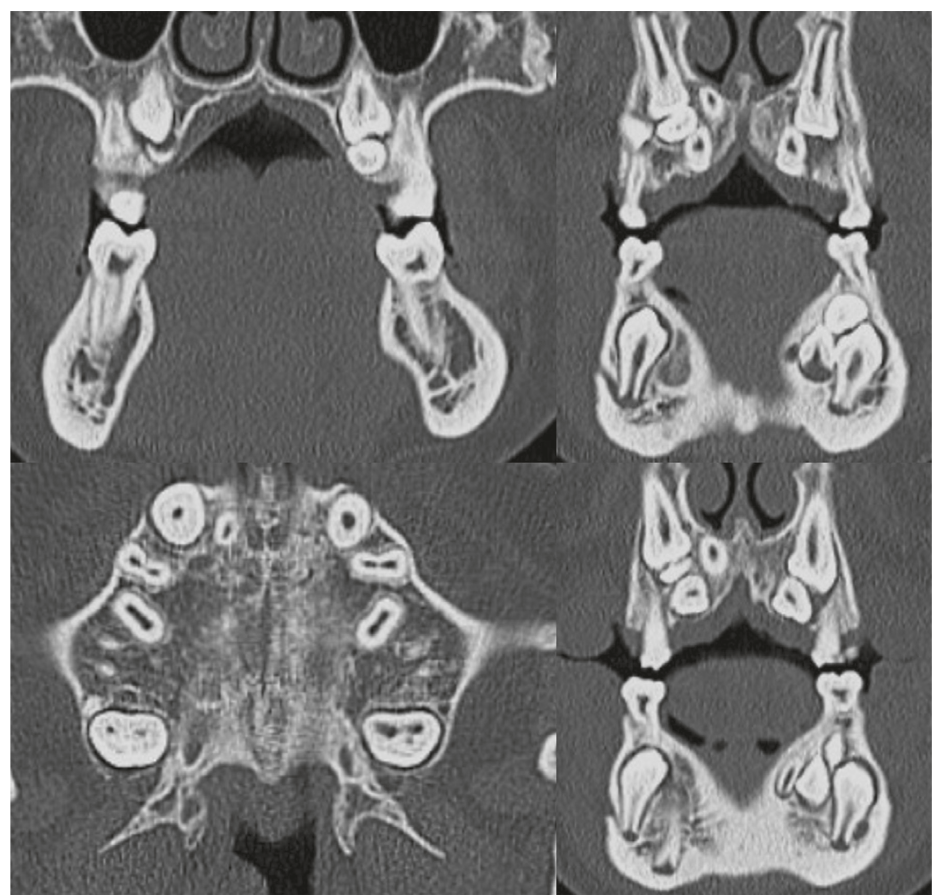
Figure 14: TC dentascan of both arches.